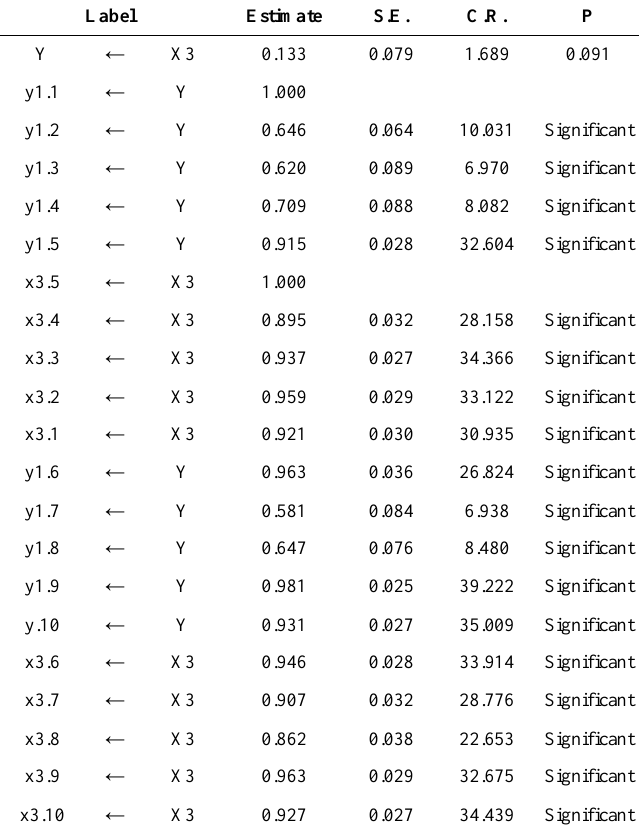
Figure 4. Exogenous Construct Model of Compensation Variables on Business Existence Table 5. Results of IV and CR Tests of Compensation Exogenous